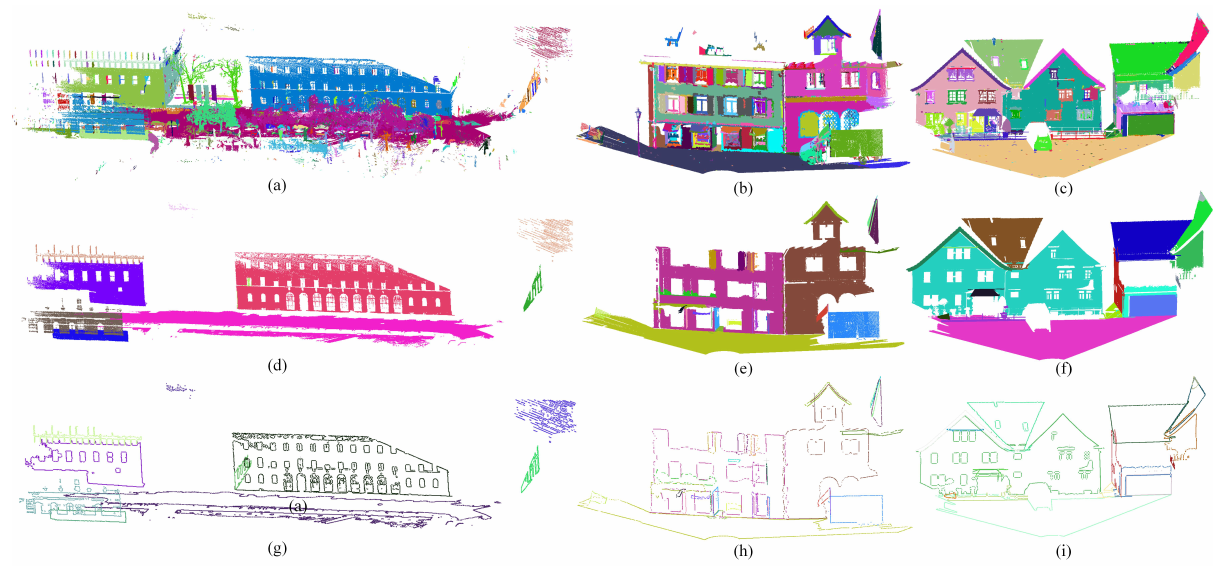
Figure 7. Illustration of segmentation results using global graph-based clustering. (a) Segmentation result of the TUM scene (Arcisstrasse), (b) segmentation results of the Town Square scene, and (c) segmentation results of the St. Gallen scene. Illustration of extracted planes. (d) Extracted planes of the TUM scene (Arcisstrasse), (e) extracted planes of the Town Square scene, and (f) extracted planes of the St. Gallen scene. Illustration of extracted hulls. (g) Extracted hulls of the TUM scene (Arcisstrasse), (h) extracted hulls of the Town Square scene, and (i) extracted hulls of the St. Gallen